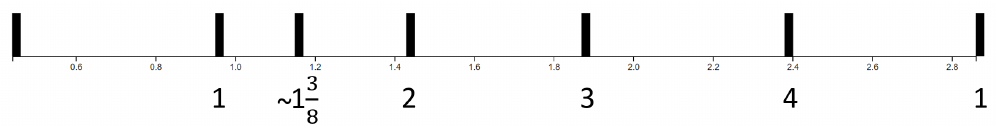
Figure 14. A tango part representing the regular “1-2-3-4” beats that match the meter and a syncopated off-beat (third onset from the